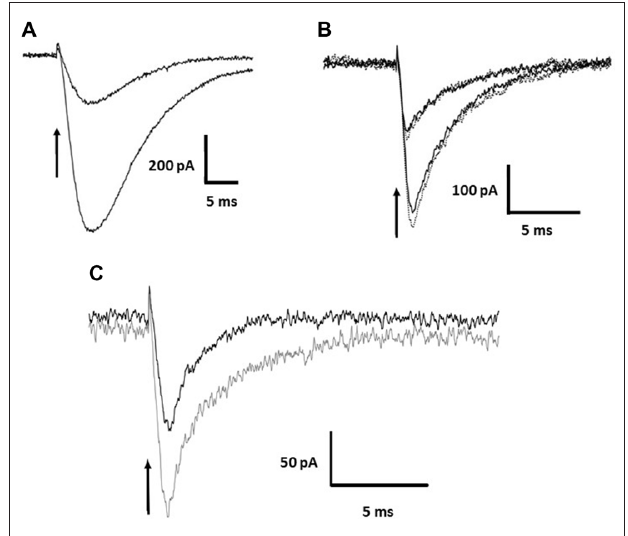
FIGURE 2 | Current evoked by photolysis of MNI-caged γ - D GG or MNI-caged γ - L GG. (A) Currents evoked by photorelease of L -glutamate at 3 µ M and 7 µ M in a Purkinje cell. (B) Currents of similar amplitude evoked by photorelease of 0.5 or 1.0 mM γ - D GG, in the absence (solid black traces) or presence (dotted gray traces) of the AMPA/Kainate receptor antagonist NBQX (30 µ M). Currents evoked by γ - D GG are faster than the glutamate evoked currents and are not affected by the high affinity AMPA receptor competitive antagonist NBQX, indicating that γ - D GG is not an agonist of AMPA/Kainate receptors. (C) To test for an effect of the protons co-released with γ - D GG and γ - L GG (see Scheme 1 ), photorelease of 1.0 mM γ - L GG was compared in saline buffered with 70 mM HEPES (black trace) or 10 mM HEPES (gray trace). High proton buffering reduced the amplitude of the currents. Time of release indicated by the